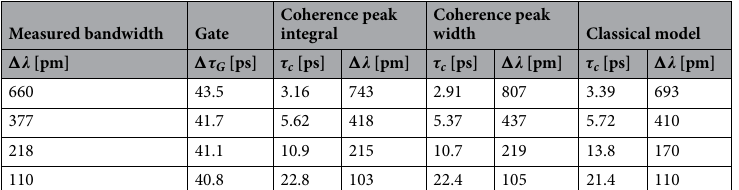
Measured bandwidth